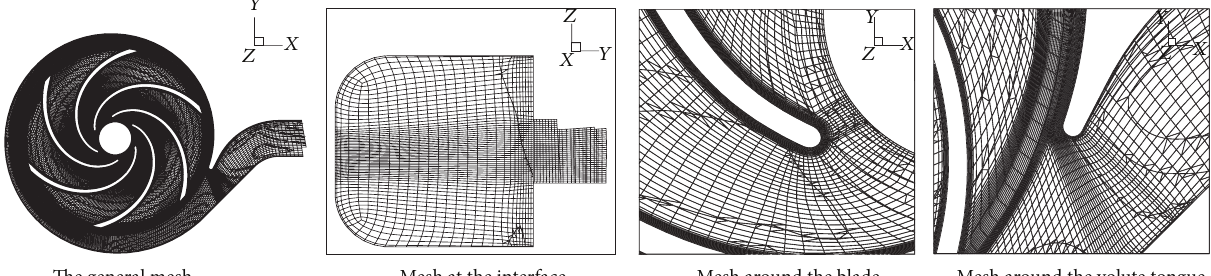
Figure 4: The 2nd level grid: 982784 points.